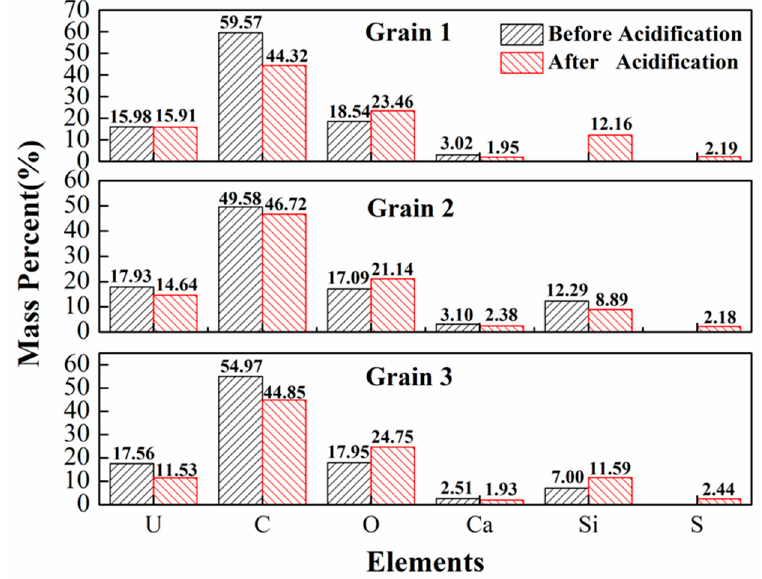
Figure 14. Variation characteristics of elements before and after acid leaching.